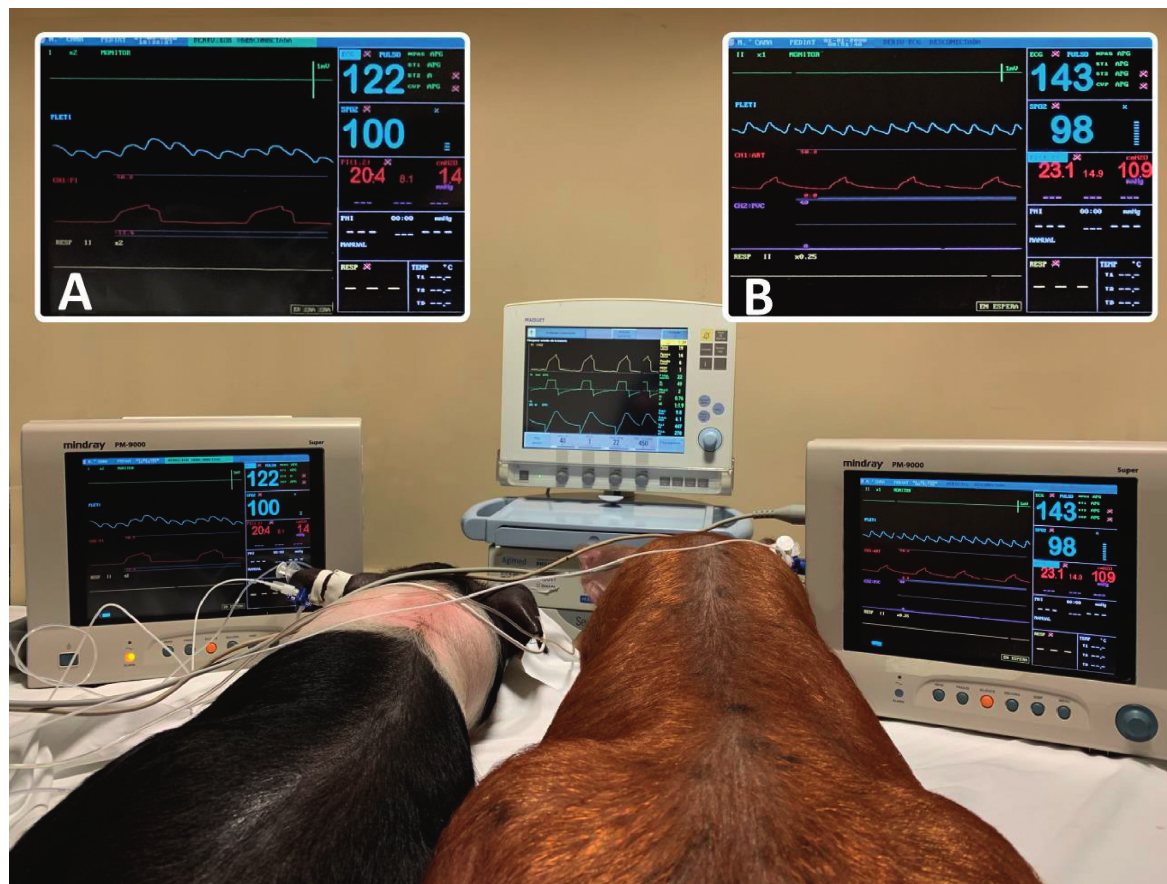
Figure 3: Two animals, weighing 12kg (left) and 25kg (right), are shown being ventilated simultaneously with a single ventilator and the DuplicAR Ⓡ device. The pressure-time curve of each animal is displayed in cmH 2 O in each multiparameter monitor (in detail in (a) and (b)). In (a), the peak pressure is 20.4 cmH 2 O, while the PEEP is 1.4 cmH 2 0. In (b), the peak pressure is 23.1 cmH 2 0, and the PEEP is 10.9 cmH 2